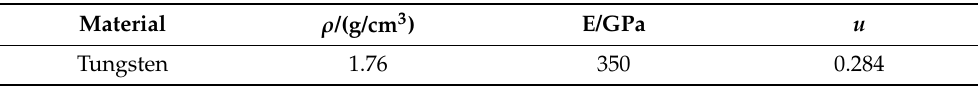
Table 2. Evasion material